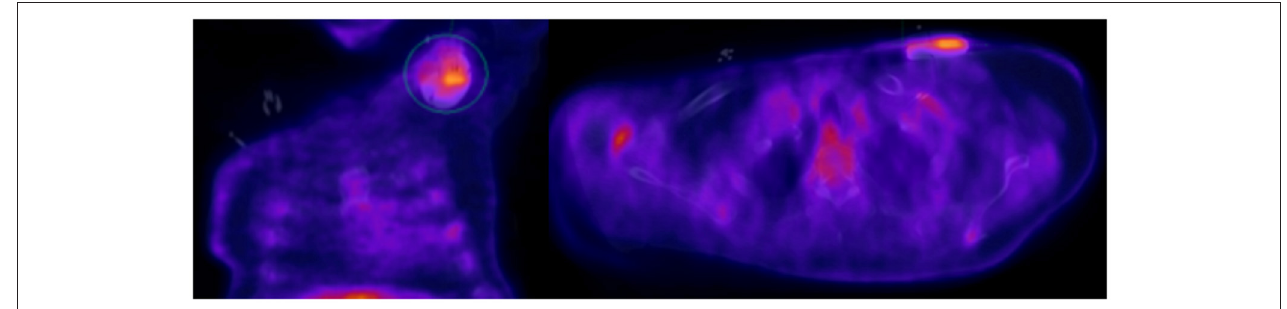
FIGURE 1 | Seventy year-old male with sick sinus syndrome s/p dual chamber PPM 2 years prior, who presented with fever. PPM pocket site with mild tenderness on palpation but no obvious signs of infection. Infectious work up was unremarkable but given ongoing fever and high clinical suspicion for pocket infection, an 18 F-FDG PET-CT was obtained showing increased FDG pocket uptake consistent with pocket infection. The patient underwent complete system